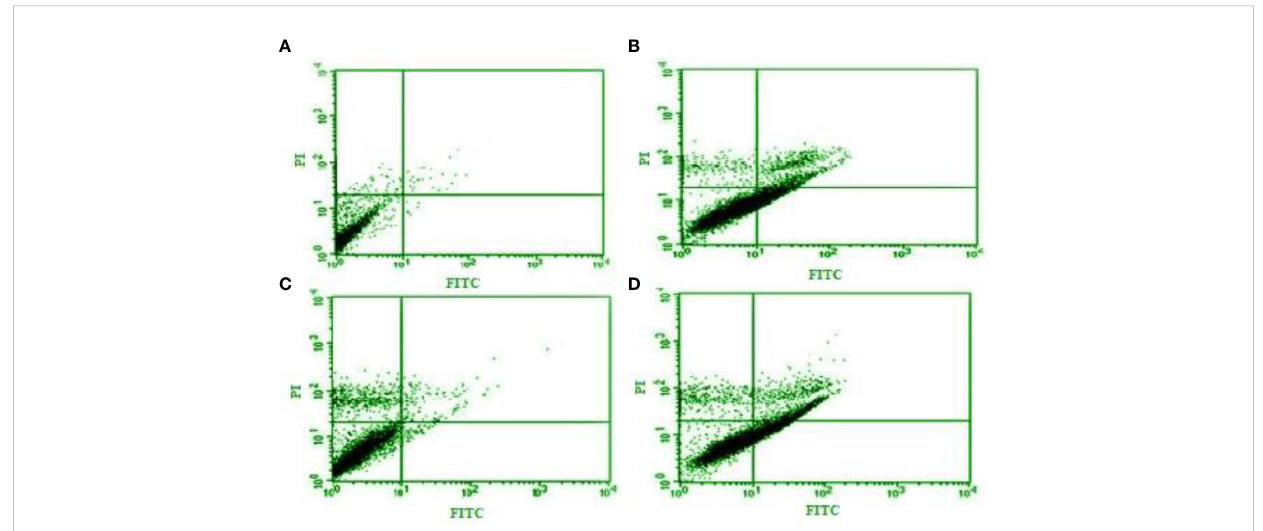
FIGURE 2 Flow cytometry and apoptosis analysis of Curcuma longa essential oil at 12.5, 25, and 50 µg/ml (B – D) on the apoptotic and necrotic cells in tachyzoites of Toxoplasma gondii compared with control group (A) .